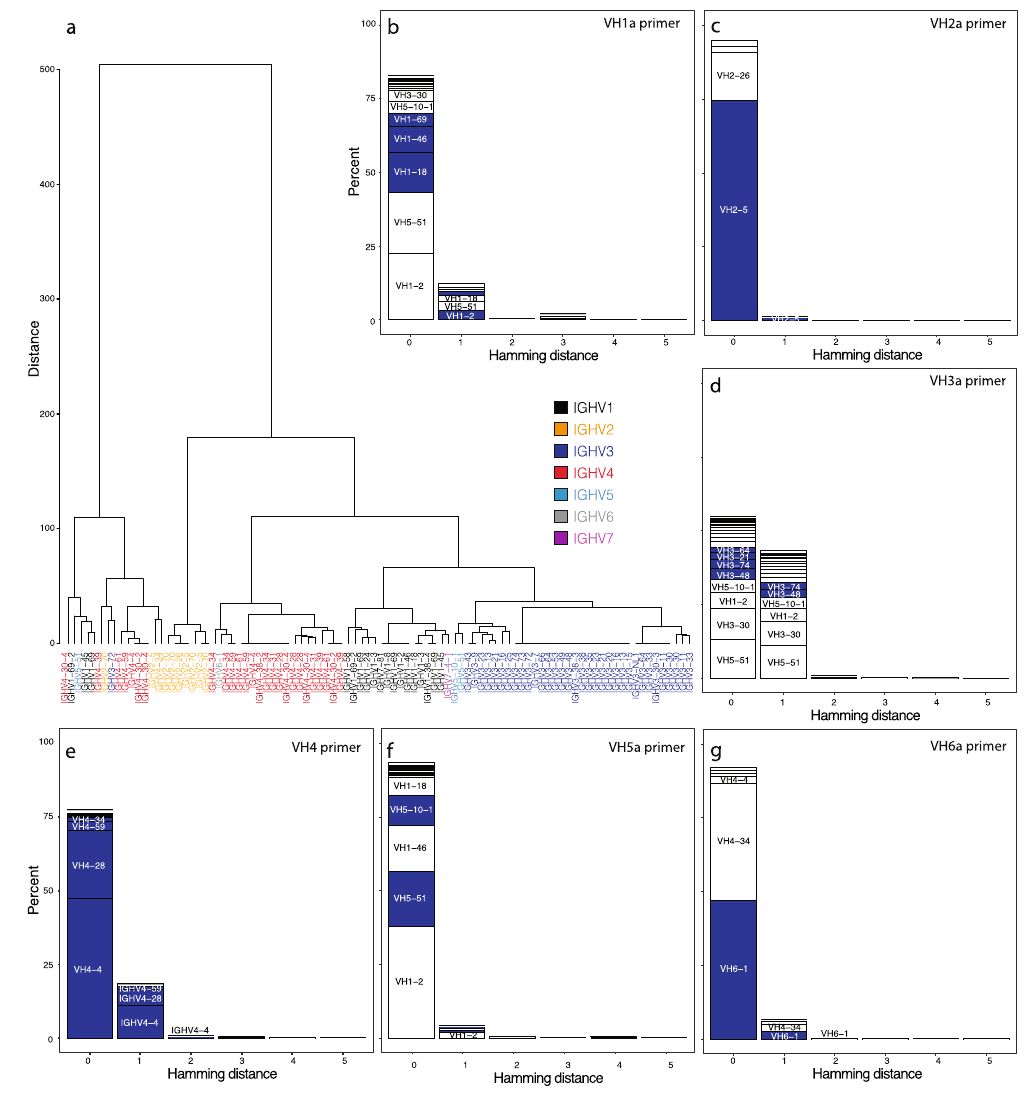
Fig. 3 Relative cluster of primer sets corresponding to germline sequences for insight into off-target. a Unsupervised hierarchical clustering of 18 bp region at 5 ′ portion of the V-region shows three predominant clusters that include many cross-family members. b Analysis of the off-target gene-family ampli fi cation for IGHV1a as an example of the primer speci fi city for the IGHV1 family. c Analysis of the off-target gene-family ampli fi cation for IGHV2a as an example of the primer speci fi city for the IGHV2 family. d Analysis of the off-target gene-family ampli fi cation of IGHV3a to represent the primer speci fi city for the IGHV3 family. e Analysis of the off-target ampli fi cation for IGHV4. f Analysis of the off-target gene-family ampli fi cation of IGHV5a to represent the primer speci fi city for IGHV5. g Analysis of the off-target ampli fi cation for